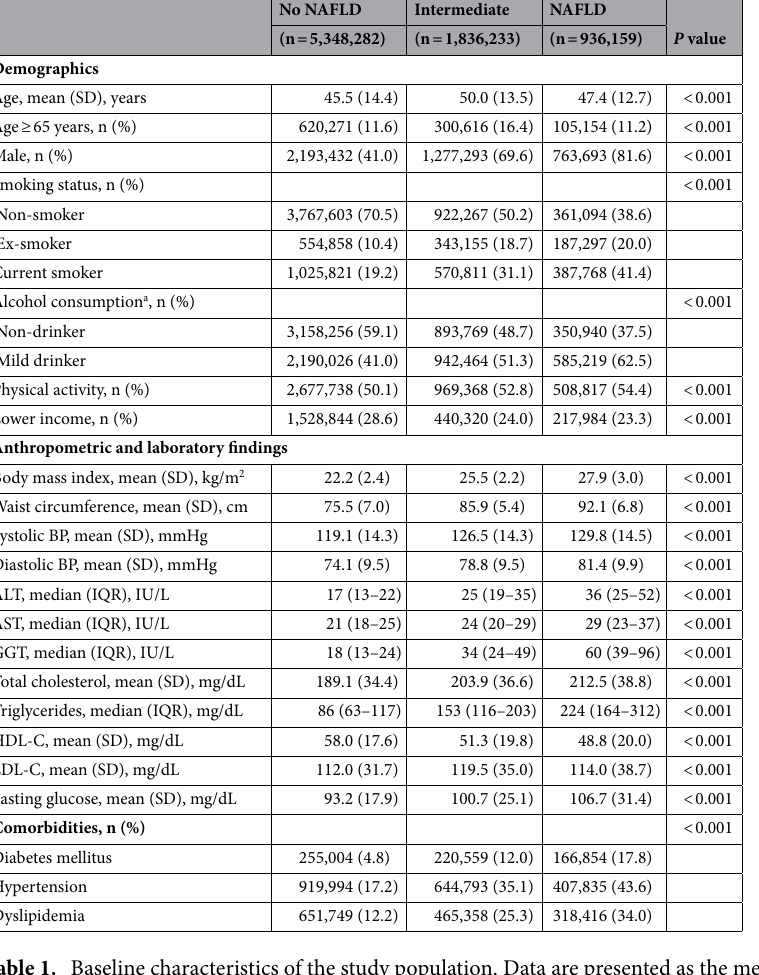
transaminase, AST aspartate aminotransferase, BP blood pressure, GGT gamma-glutamyl transferase, HDL-C high-density lipoprotein cholesterol, IQR interquartile range, LDL-C low-density lipoprotein cholesterol, NAFLD non-alcoholic fatty liver disease, SD standard deviation. a Individuals who consumed alcohol ≥ 30 g/day were initially excluded.